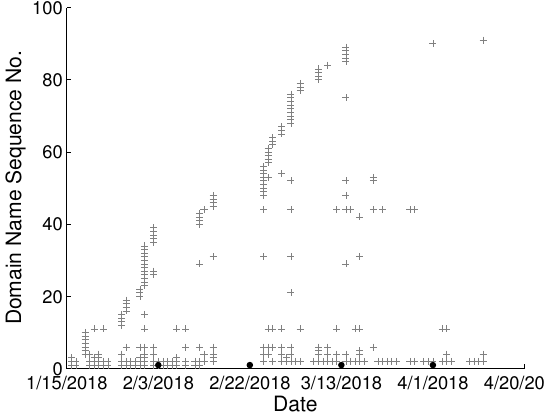
Figure 3. Domain names visited in chronological order from user B in our lab.